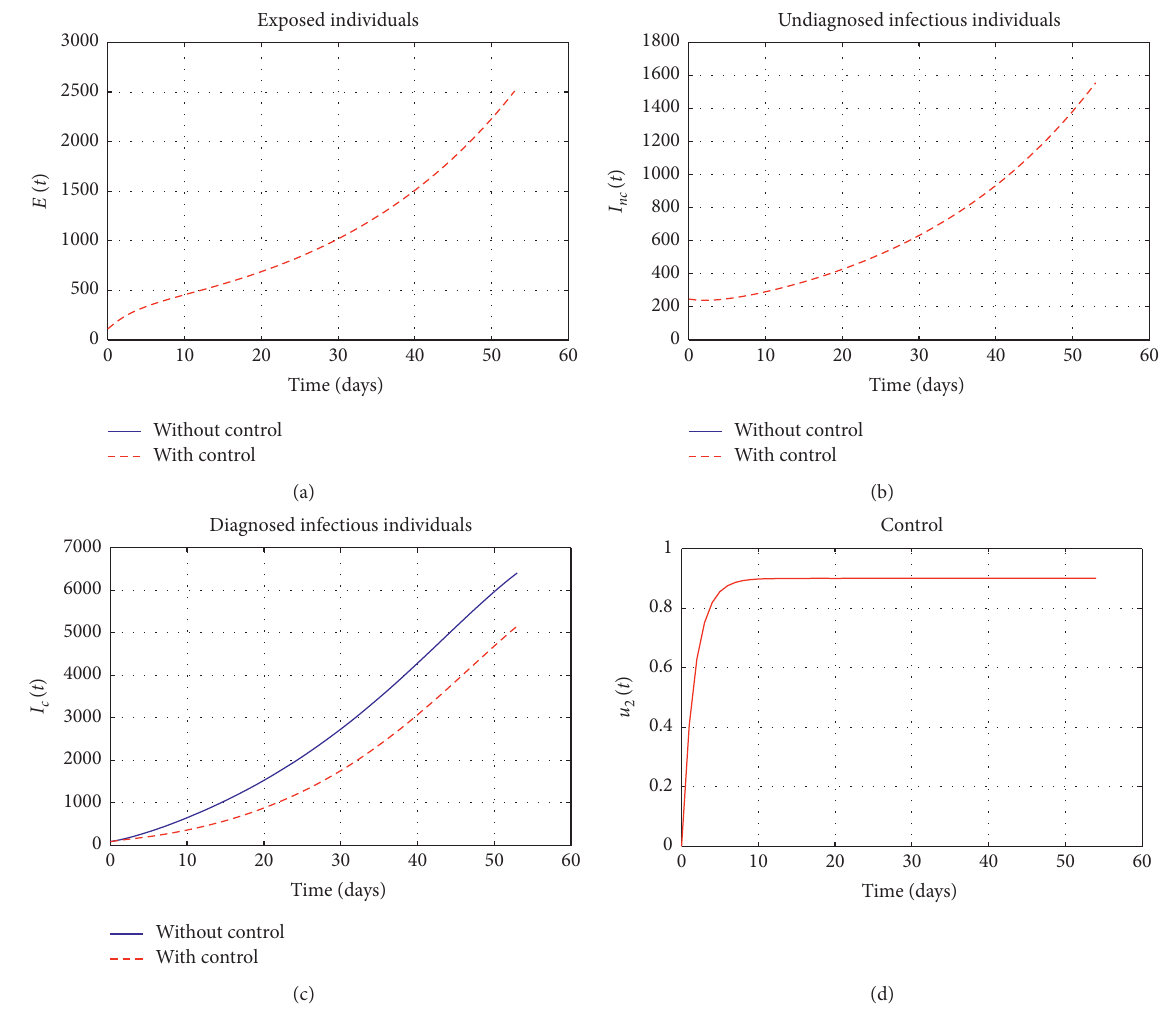
Figure 4: Number of E , I ( I nc ). (c) Confirmed and isolated individuals ( I c ) . (d) Evolution of the control u u max � 0 .